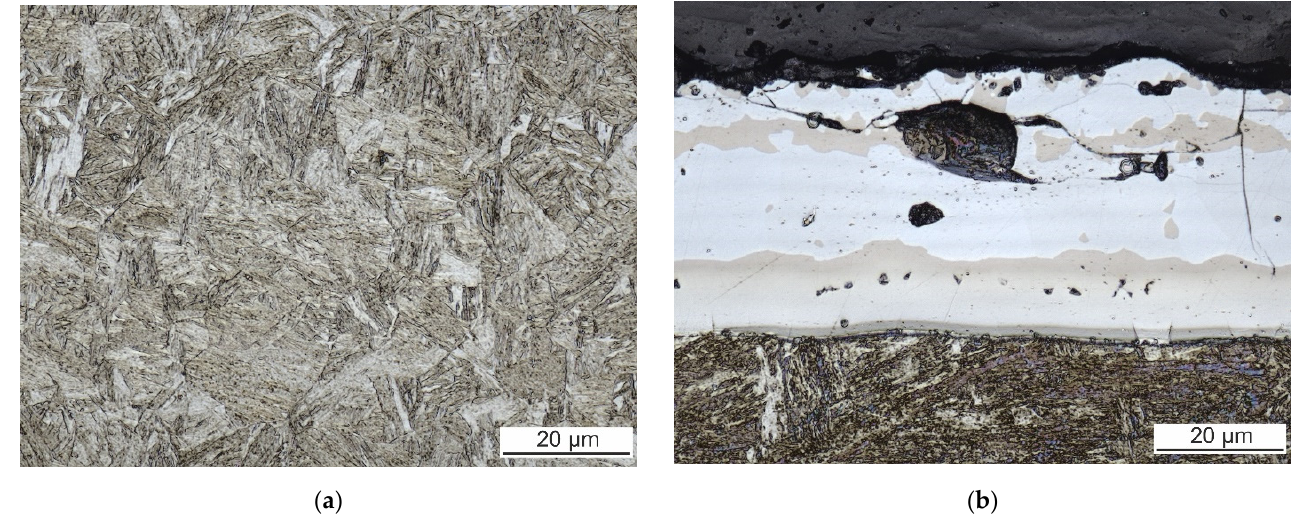
Figure 2. ( a ) Microstructure of the BM. ( b ) Microstructure of surface coating. The coating is not homogeneous due to the diffusion present during hot stamping. The EBSD analysis revealed the crystallographic structure of the coating subzones. They have also a good contrast in the confocal image (Figure 2b). The inverse pole figure (IPF) map and the corresponding phase and image quality (IQ) map of the coating–steel inter- of gamma iron, Al 8 Fe 2 Si, and Al 9 Fe 2 Si 2 was investigated. However, these phases were not found.